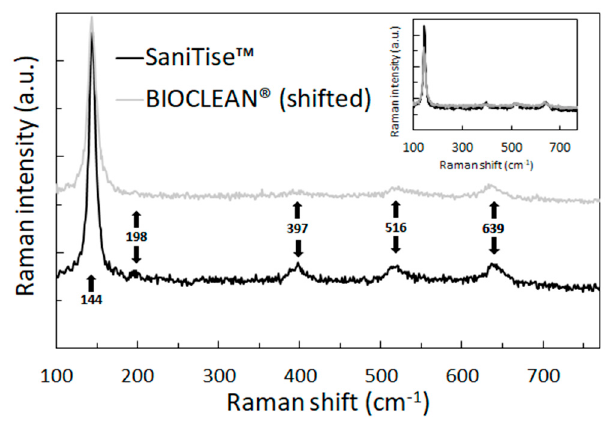
Figure 3. Raman spectra of SaniTise™ and BIOCLEAN ® glasses. The spectrum of BIOCLEAN ® is shifted in intensity scale for clarity; inset shows initial intensities. Characteristic Raman bands of anatase (marked with arrows) are observed for both glasses.